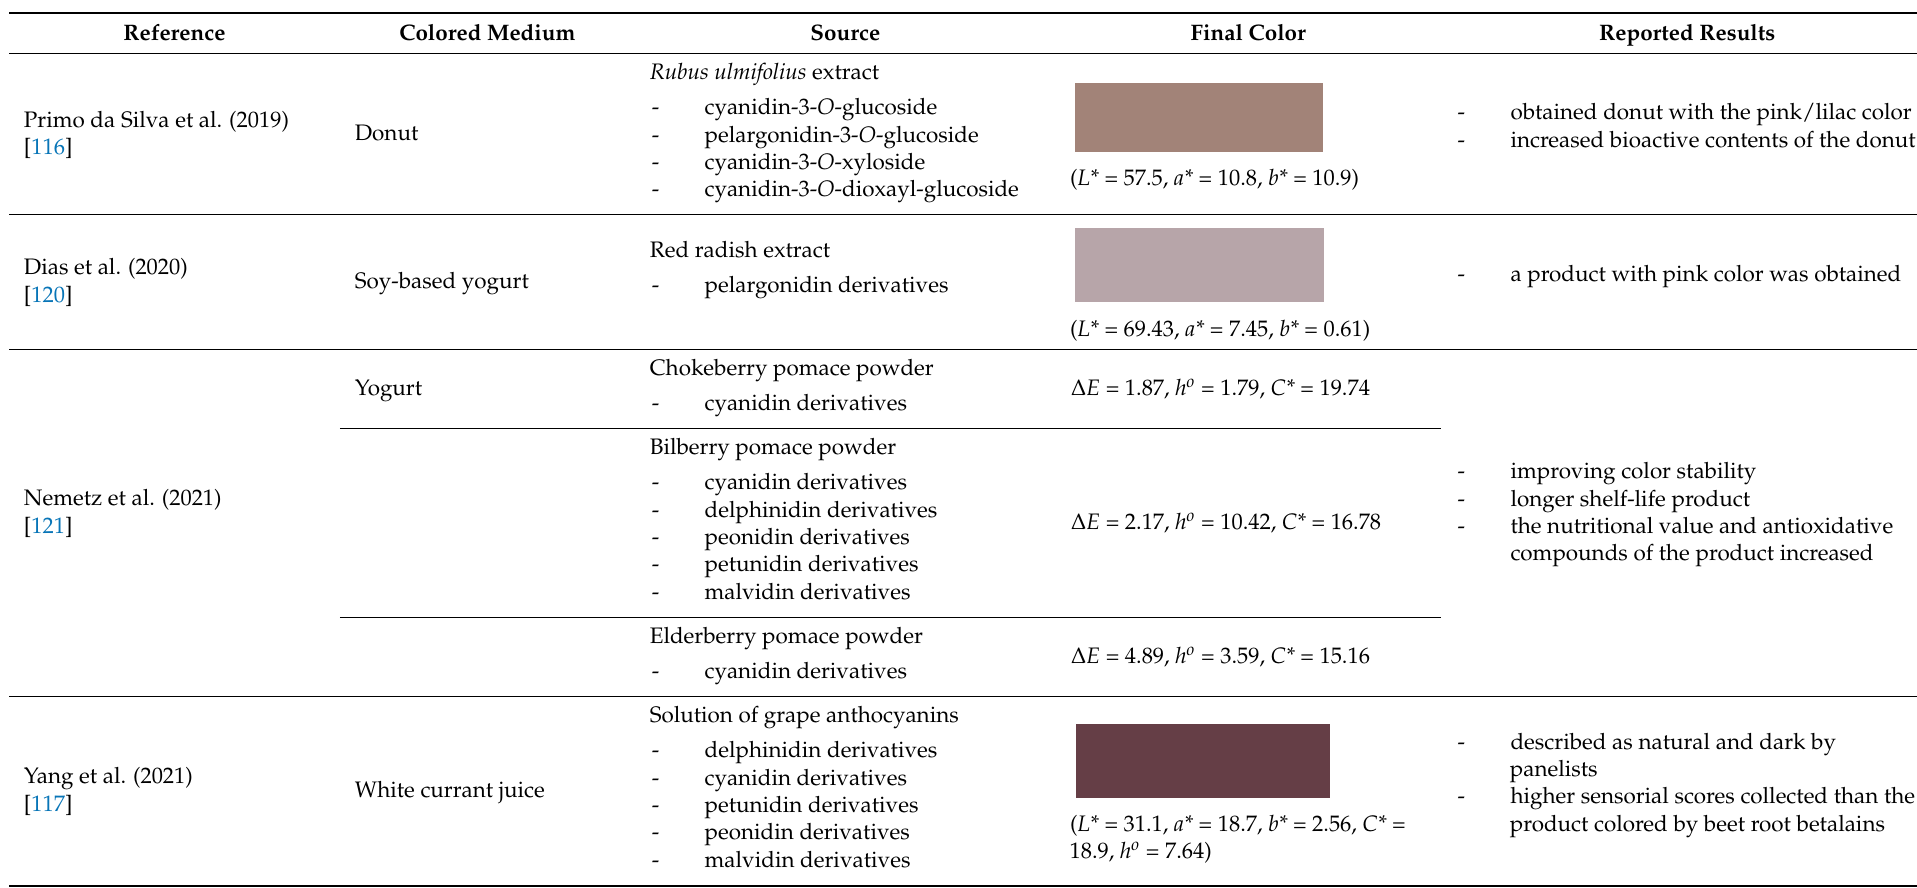
Table 3. The overview of the studies on coloring food products with anthocyanins extracted from various plant sources.